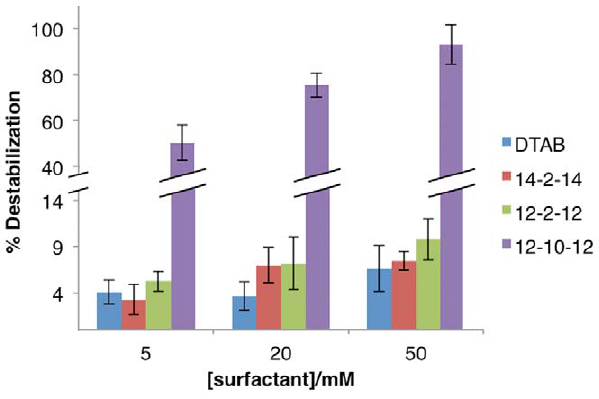
Figure 3. Membrane destabilization (% ± SD) as obtained by the calcein fluorescent die released from PE:PC:PS:CHO (1:1:1:1) liposomes, for the indicated surfactant concentra- tions. Experiments were conducted at room temperature.